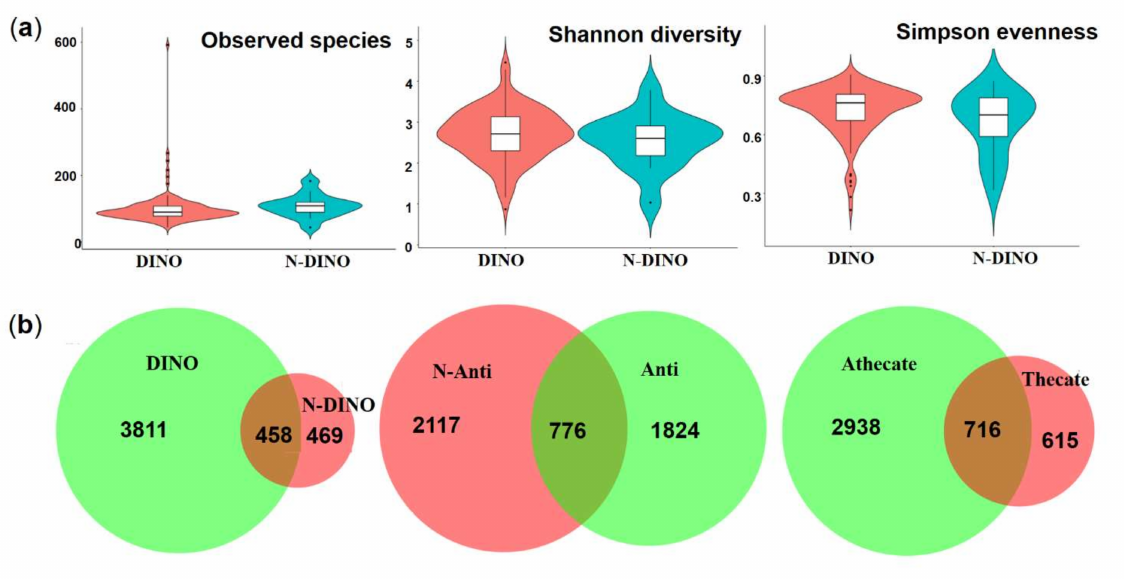
Figure 2. ( a ) Violin plots (median, min and max) showing alpha diversity (Shannon diversity, Simpson evenness and the number of observed species) of DINO (dinoflagellates) and N-DINO (non-dinoflagellates) groups. ( b ) Venn diagram showing the numbers of shared and unique bacterial features.